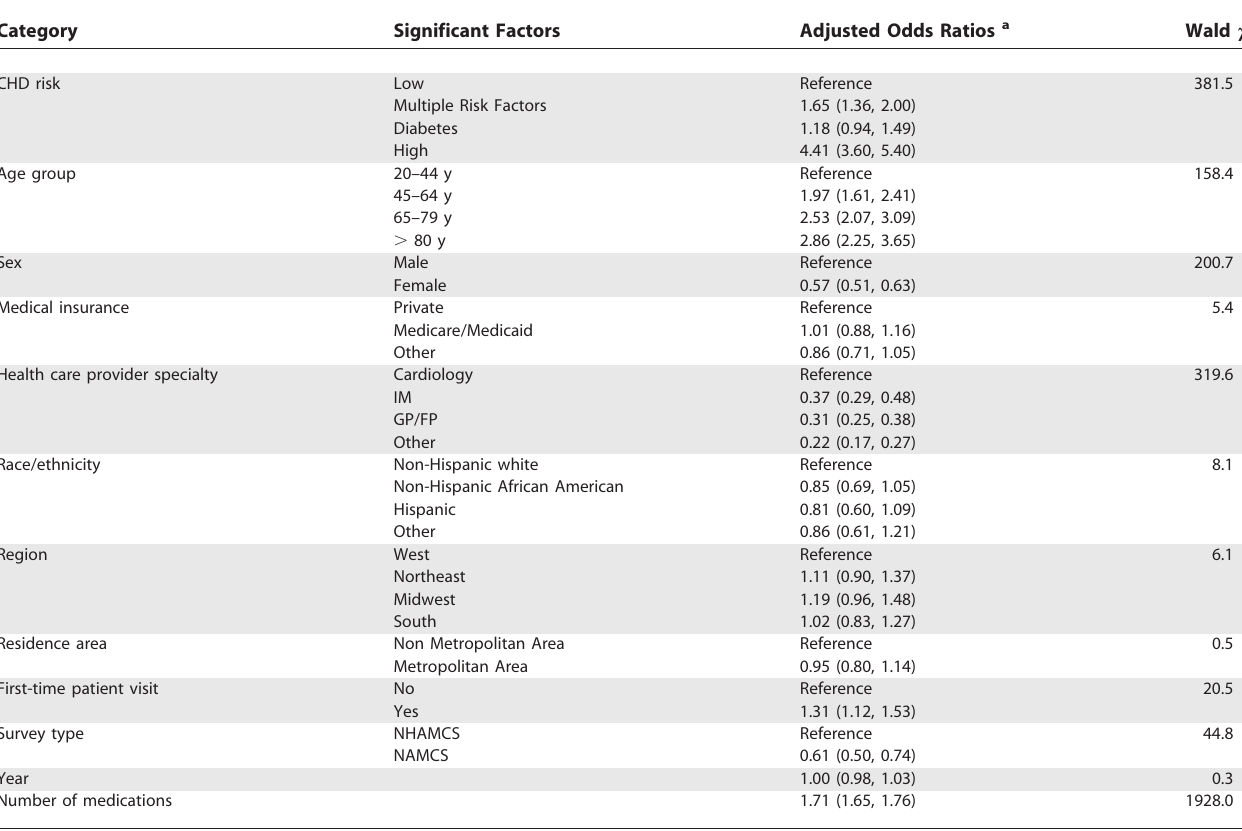
Table 1. Predictors of Aspirin Use With Combined 1995–2002 NAMCS and NHAMCS Data